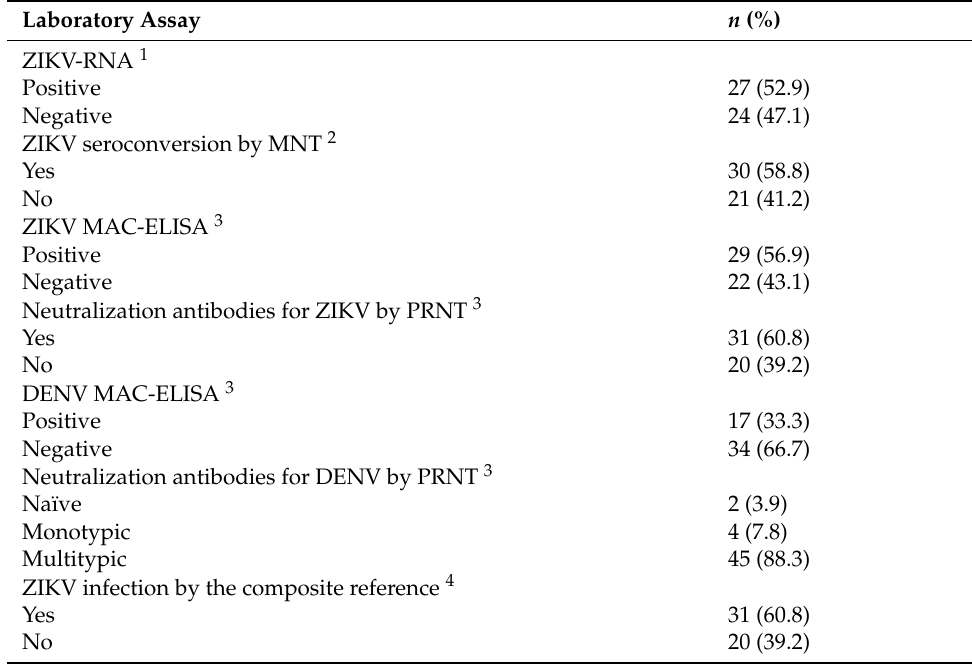
Table 1. Results for both Zika and Dengue virus diagnostic testing ( n =